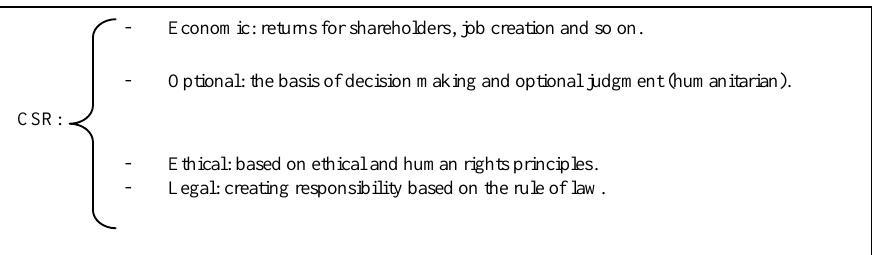
Figure (1): Corporate Social Responsibility from the viewpoint of Carroll (1979):